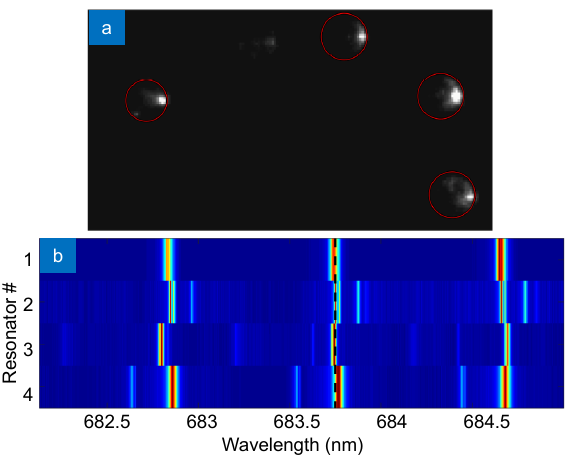
Fig. 2 | Overview of the WGM signal. ( a ) Radiated intensities for a set of four spherical microcavities (red circles show the cavity-related pixels). ( b ) Definition of the captured signal in terms of the WGM spectrum (black dash line marks the illumination